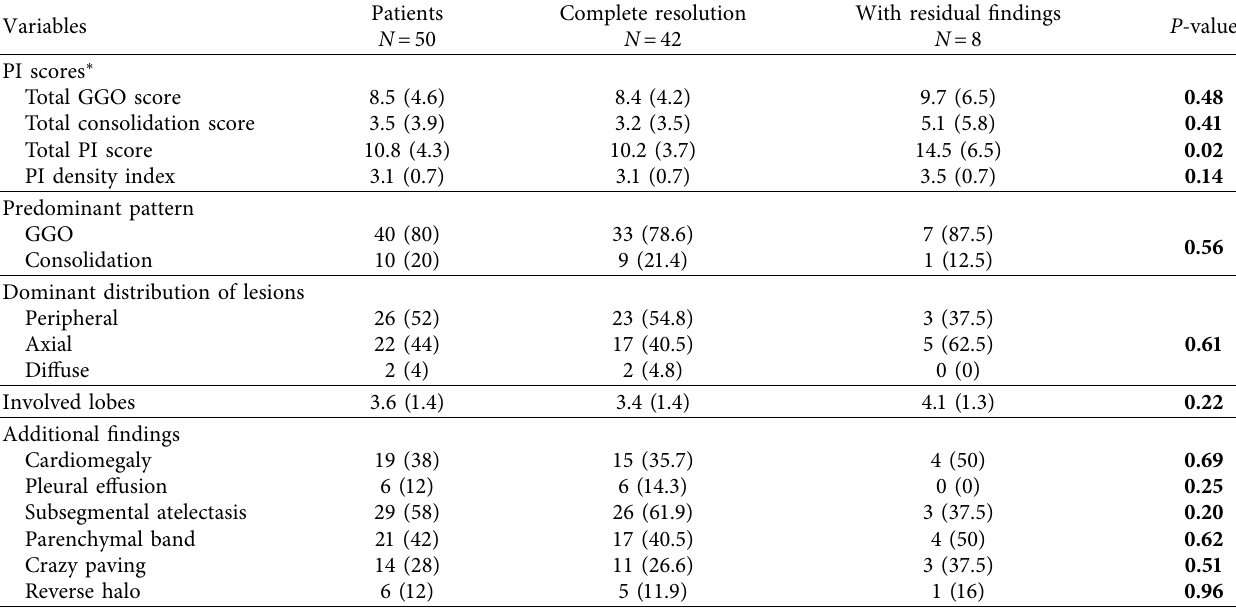
Table 2: Radiologic fndings in all patients and diferences between the two